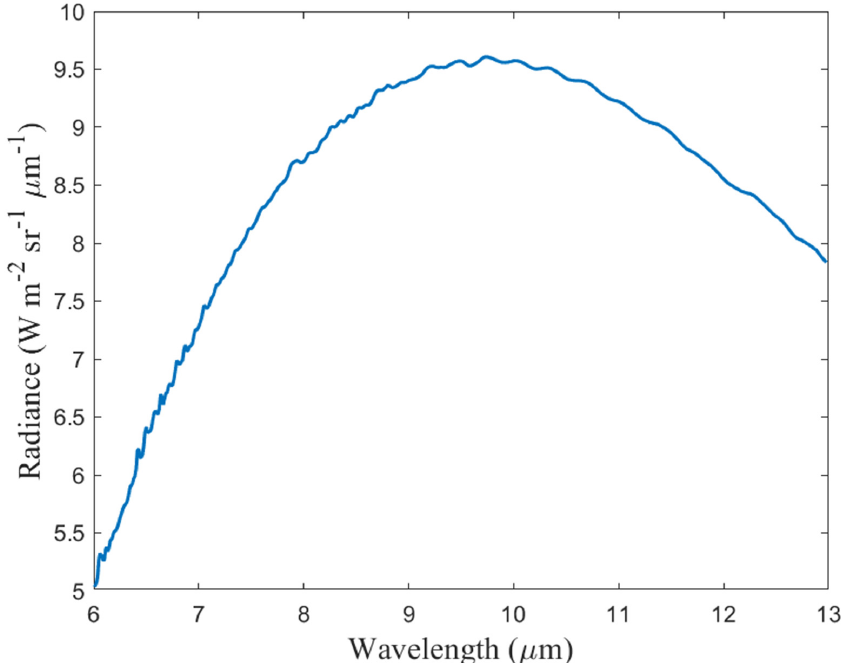
Figure 9. Off-water radiance of Ulansuhai Nur.